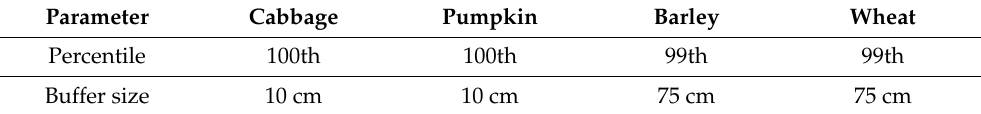
Table 3. Optimal parameter setting for the UAV-based height estimation consisting of percentile and buffer size for cabbage, pumpkin, barley, and wheat crops for an intercropping field. Parameter Cabbage Pumpkin Barley Wheat Percentile 100th 100th 99th 99th Buffer size 10 cm 10 cm 75 cm 75